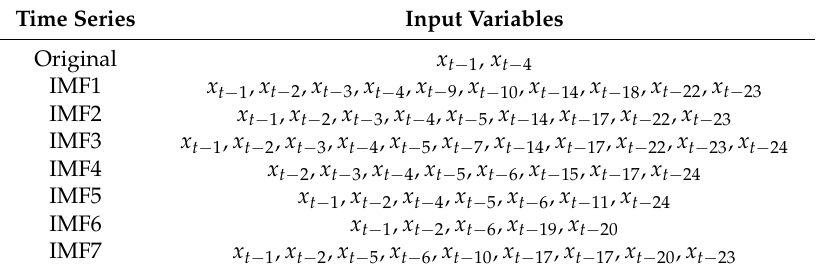
Table 3. Input variables determined by